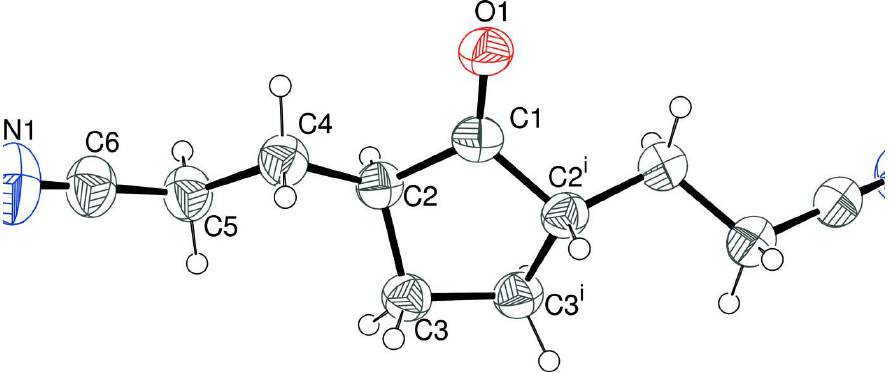
Figure 1 A view of the molecular structure of (I). Displacement ellopsoids are drawn at the 40% probability level and H atoms are shown as small spheres of arbitrary radius. Symmetry code: (i) 2 - x , y , 1/2 - z